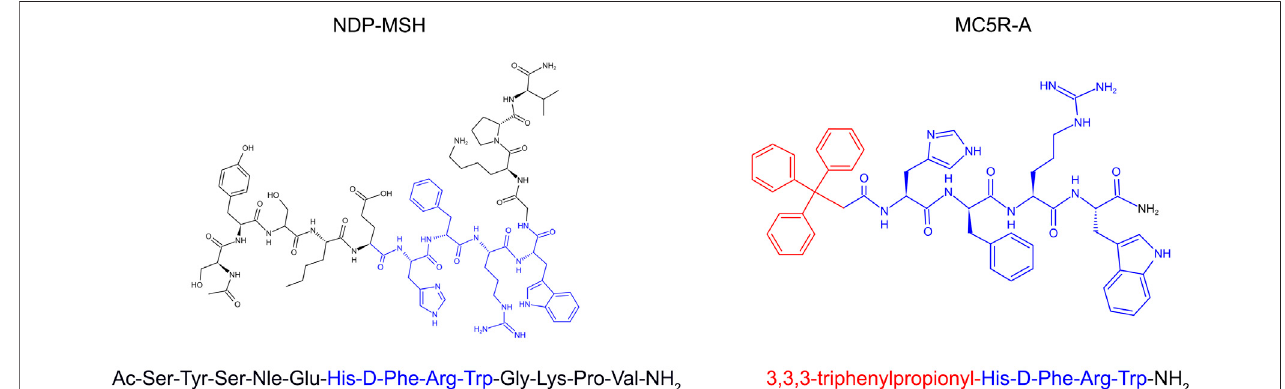
FIGURE 1 | The 2-D view of chemical structures of synthetic melanocortin peptidomimetics, NDP-MSH and MC5R-A. The melanocortin core tetrapeptide, His-D- Phe-Arg-Trp is marked in blue color. The triphenylpropionyl group of MC5R-A is marked in red color.